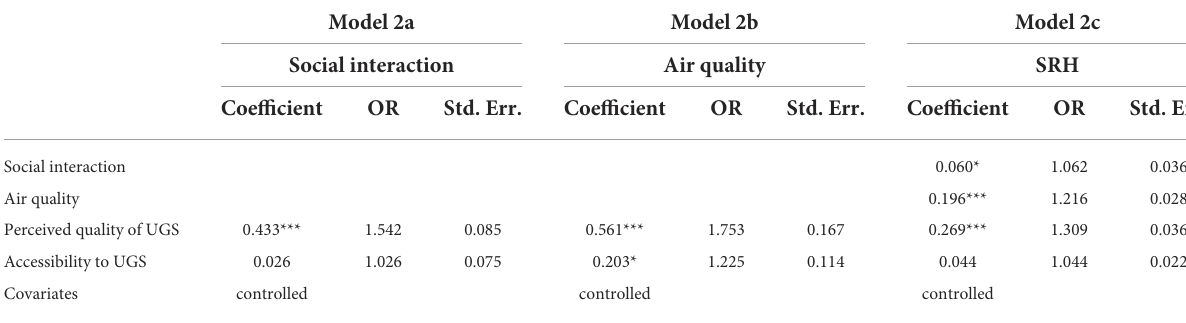
TABLE 5 Mediating effect of the association between UGS and respondents’